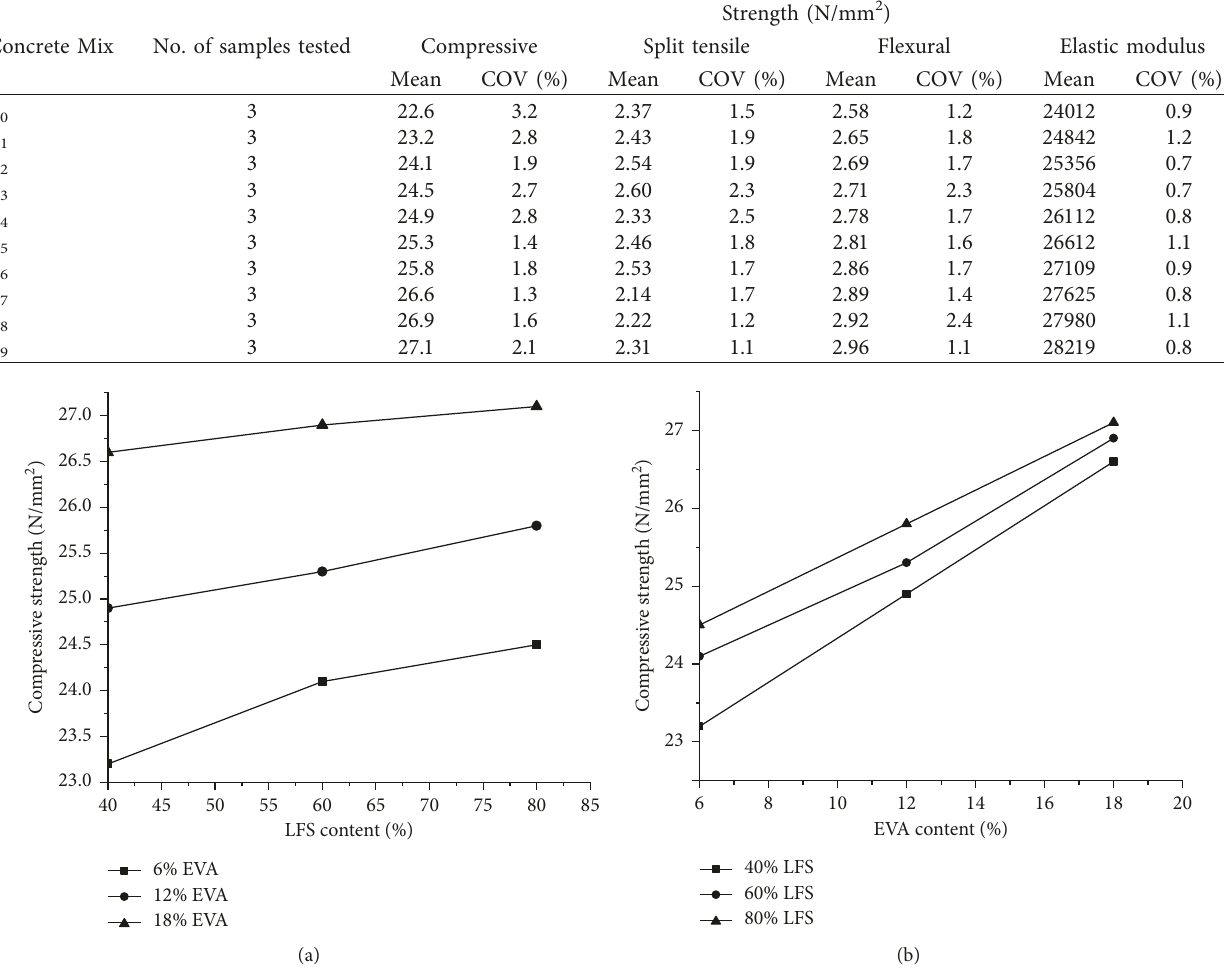
Figure 5: Comparative analysis of compressive strength at a fixed rate of (a) EVA inclusion and (b) LFS inclusion.